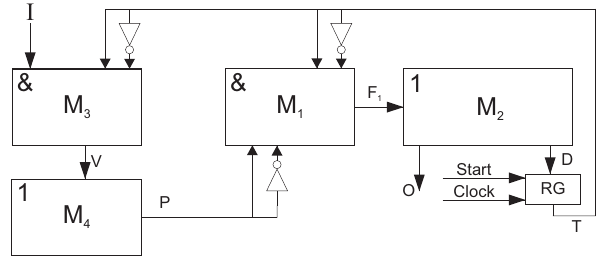
Figure 10. Structural diagram of MP Mealy